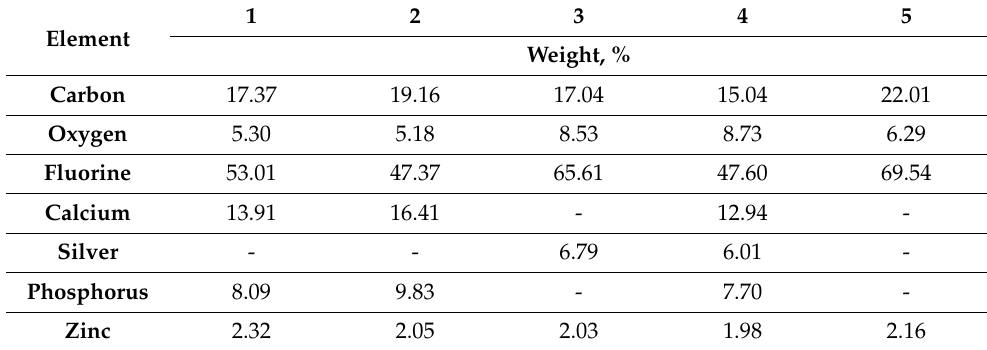
Table 2. The extracted stoichiometric values from EDX analysis of specimens.